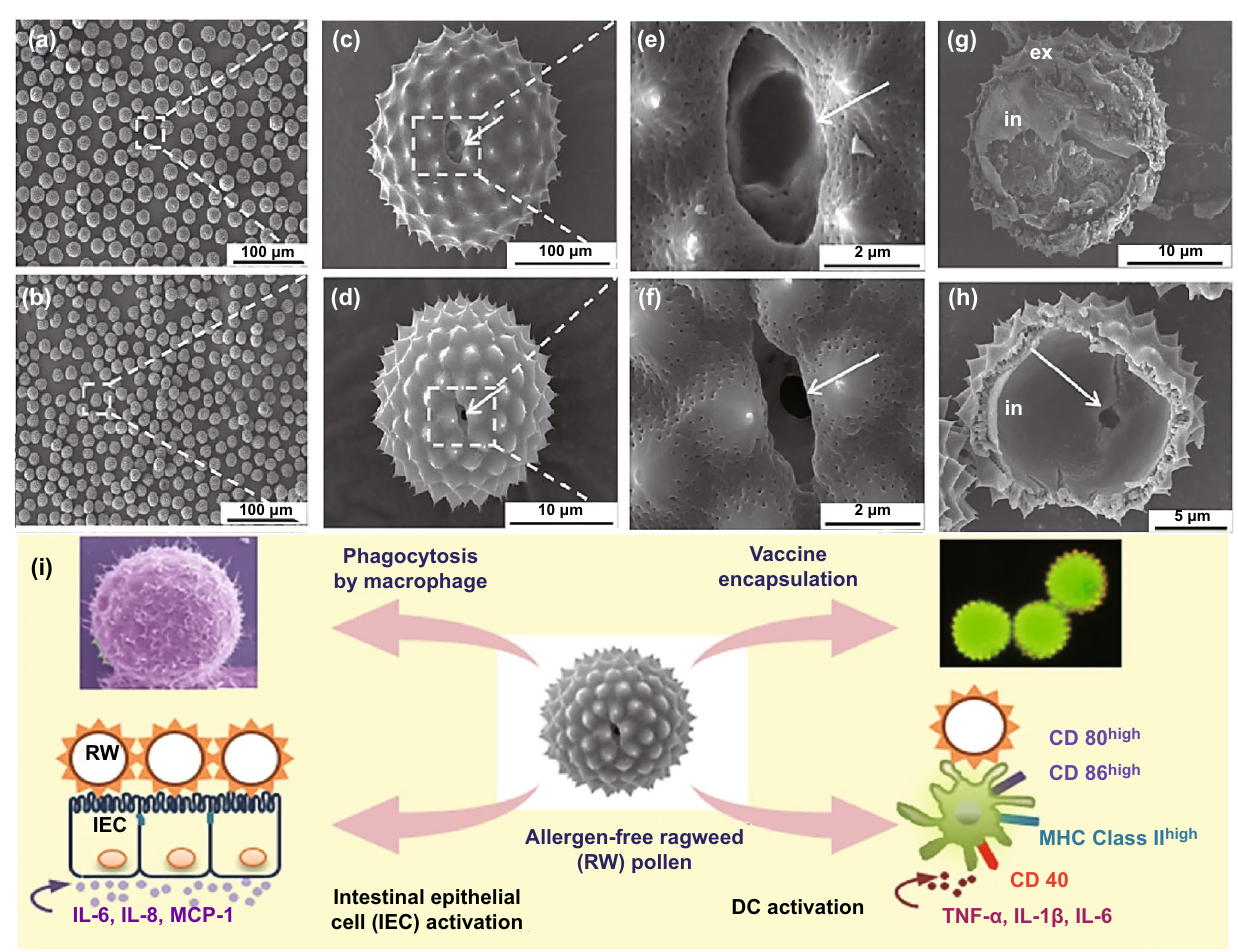
Fig. 8 SEM images of ragweed pollen grains before a , c , e , g and after b , d , f , h chemical treatment. i The design of oral vaccine delivery sys- tem using ragweed pollens. Reproduced with permission from Ref. [18]. (Color figure